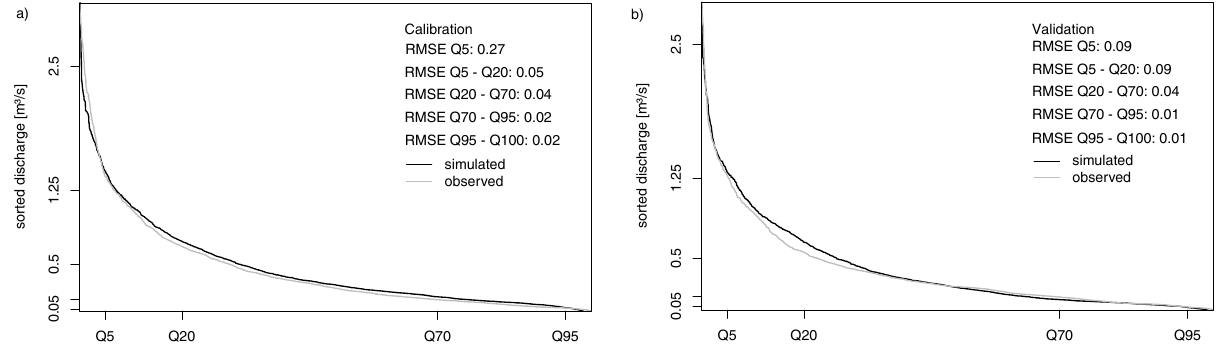
Figure 6. Flow duration curve of observed (grey) and simulated (black) discharge magnitudes for the calibration period (a) and the validation period (b) . The model performance is depicted with root-mean-square error (RMSE) of the different flow duration curve segments according to Pfannerstill et al.